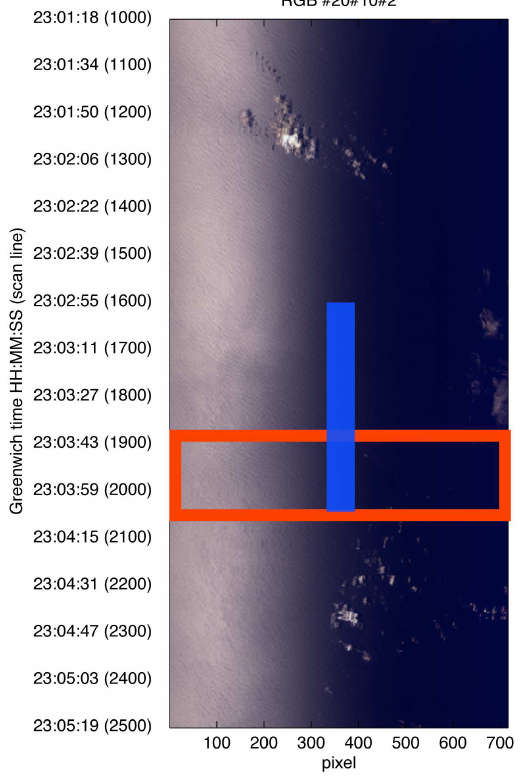
Fig. 3. MAS imagery on Pacific Ocean SE from Hawaiian Islands on 22 February 2003, from 23:01 to 23:05UTC (roughly 50km on the ground). The RGB image is obtained from channels 20 (2.15µm), 10 (1.64µm), 2 (0.55µm). The blue line and the red box show the regions chosen for the cross-scan and nadir